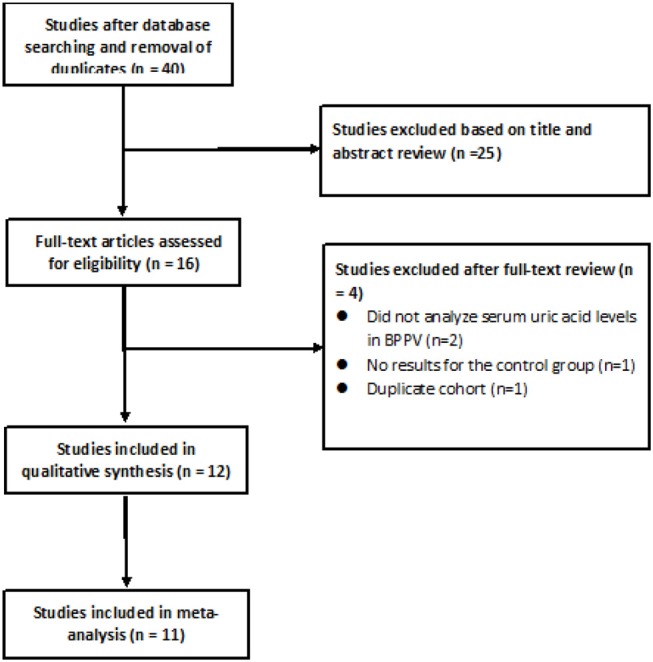
Flow diagram of study selection.